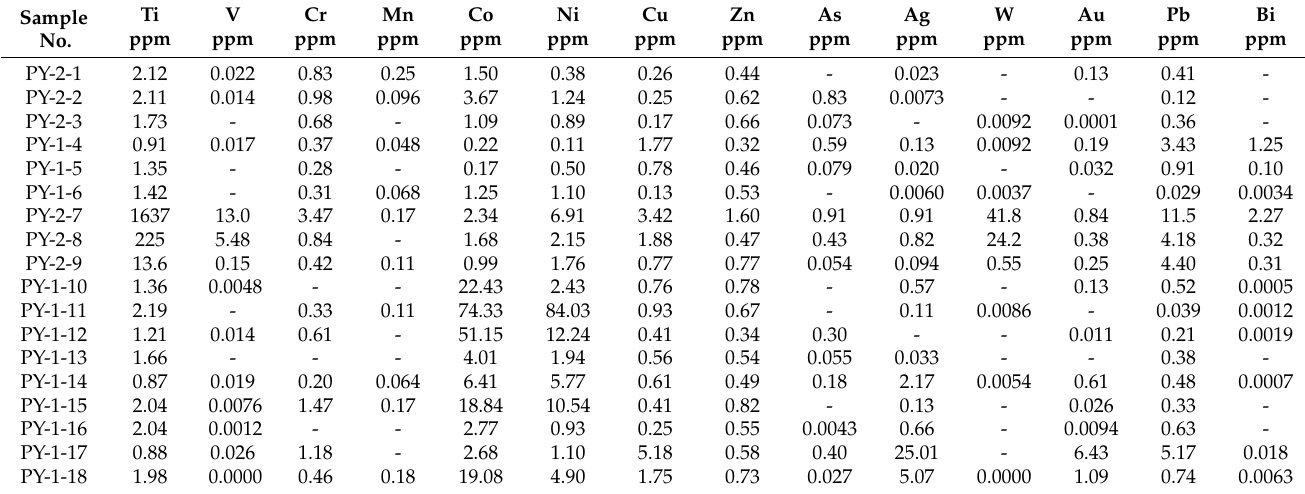
Table 4. Selected LA-ICP-MS analyses of pyrite grains from the Dongping